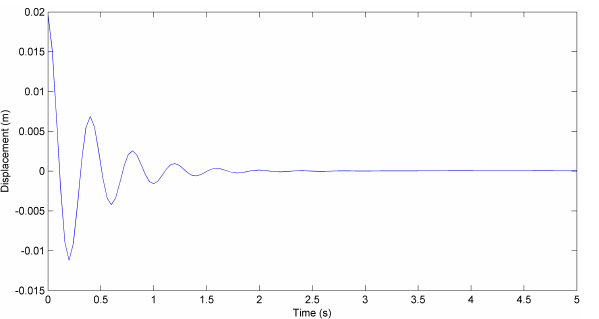
Figure 8: Forced vibration with nonzero initial